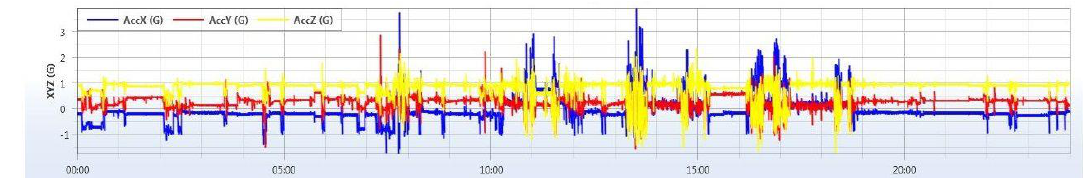
Figure 6. Example of the raw tri-axial accelerometer data of one subject for one measurement day. One measurement day (24 h) is represented on the x -axis. G-forces per sensor axes (X, Y and Z) are represented on the y -axis.